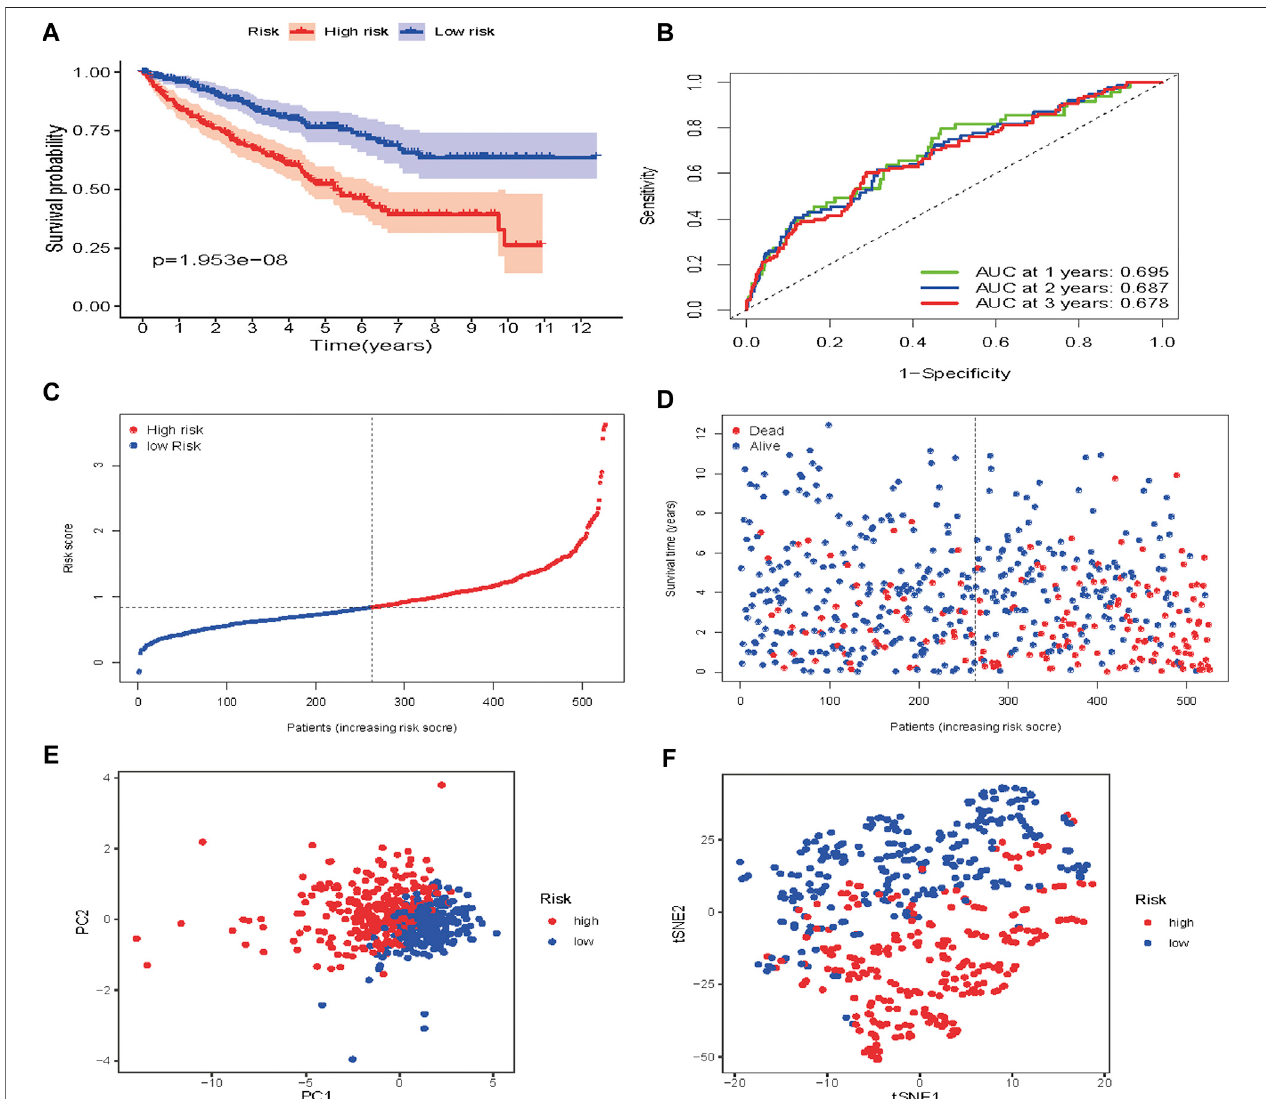
FIGURE8| Risk scoreanalysisoftheseven-geneprognostic modelin TCGA cohort (A) Kaplan-Meiercurves for theOSofpatientsinthe high-riskgroup and low- risk group in the TCGA cohort (B) AUC of time-dependent ROC curves veri fi ed the prognostic performance of the risk score in the TCGA cohort (C) Distribution and median value of the risk scores in the TCGA cohort (D) Distributions of OS status, OS and risk score in the TCGA cohort (E) t-SNE analysis of the TCGA cohort (F) PCA plot of the TCGA cohort.